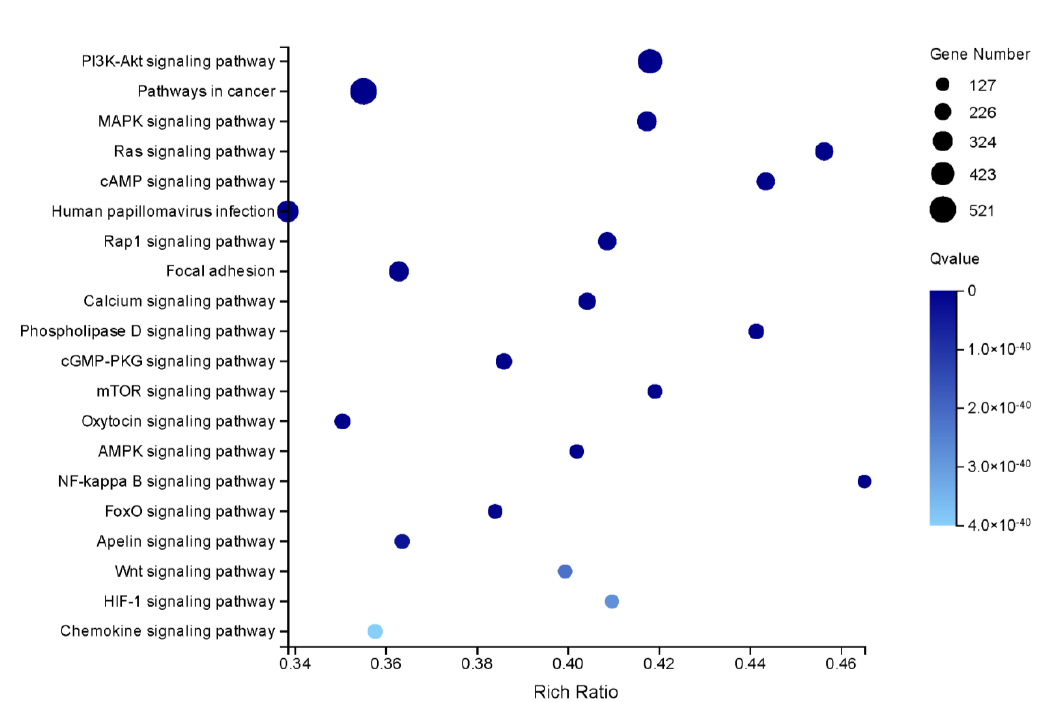
Figure 4. Scatter plots of Gene expression profiles in female and male S . elongata . Thresholds for inclusion were defined by p −value ≤ 0.01 and |log 2 fold change| ≥ 1.